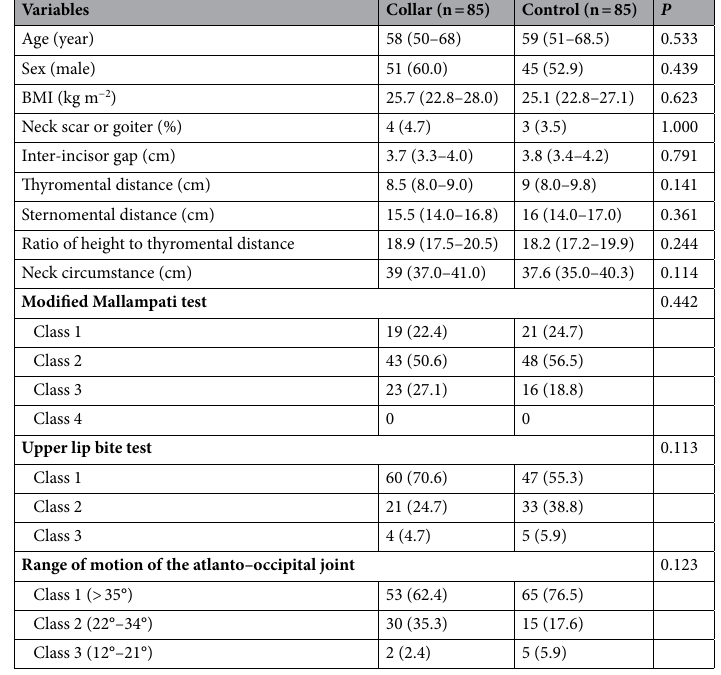
Table 1. Patient characteristics. Data are presented as median (interquartile range) or number (%).